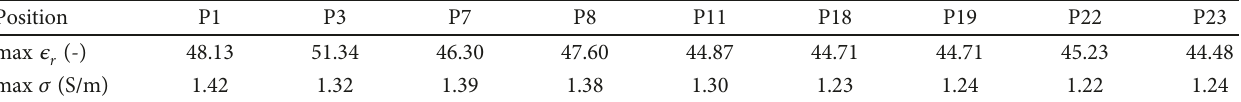
Figure 6: Detection of position of the strokes from reconstructed images. Circles mark the actual position of the stroke; dots of adequate color show the detected positions. Table 2: Maximal values of dielectric parameters for the selected positions of the stroke phantom after the